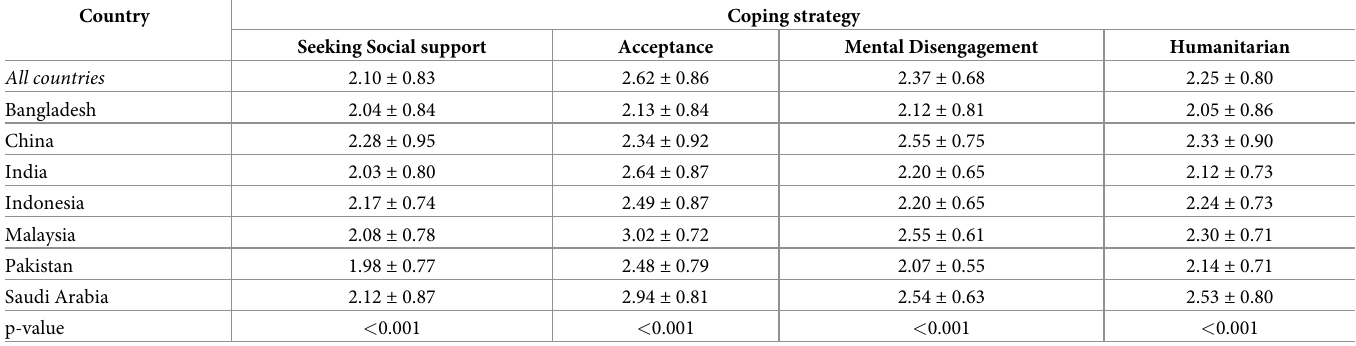
Table 4. Descriptive summaries for the four coping strategies by